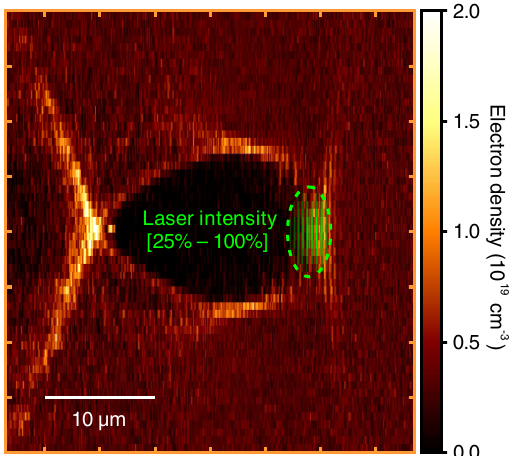
FIG. 9. A zoomed-in slice of the laser intensity (green) and electron density near the focus at s ¼ 5 . 23 mm. The tightly focused laser drives a wakefield and features a peak laser strength of a 0 ¼ 3 . 35 , which is close to the maximum a 0 ¼ 3 . 5 at the vacuum line focus. The laser intensity scale (green) ranges from 25% to 100% relative peak